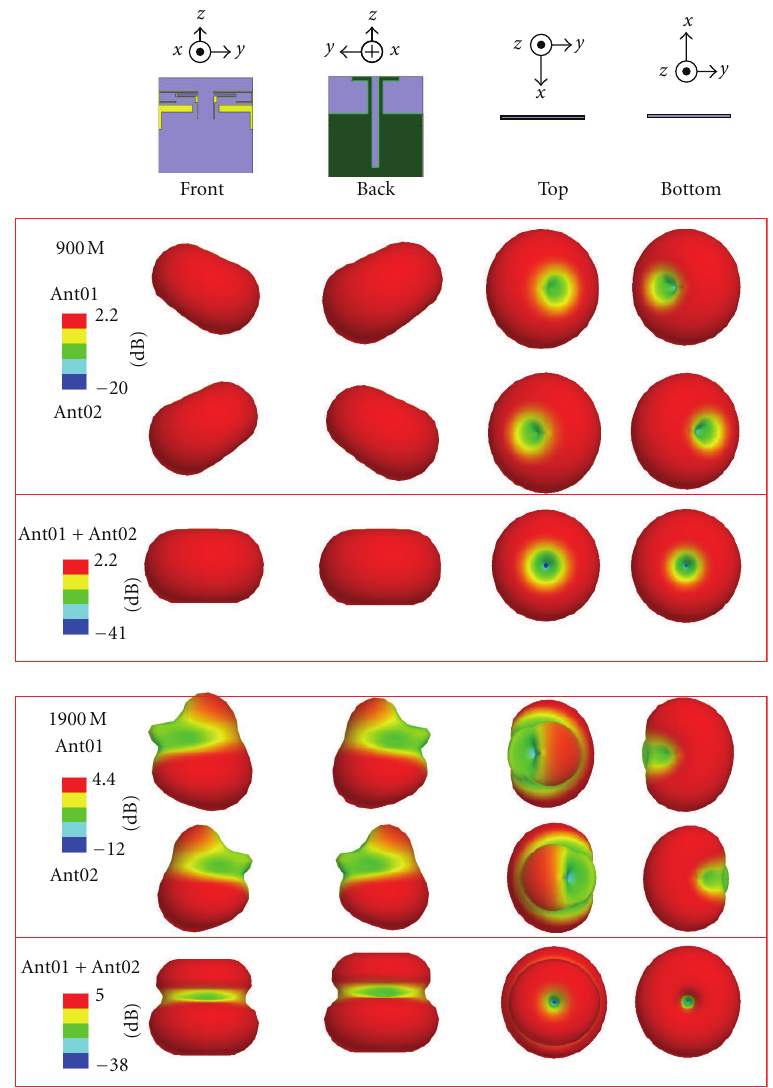
Figure 4: Simulated total power 3D radiation pattern of antenna no. 1 and antenna no. 2 at 900MHz and 1900